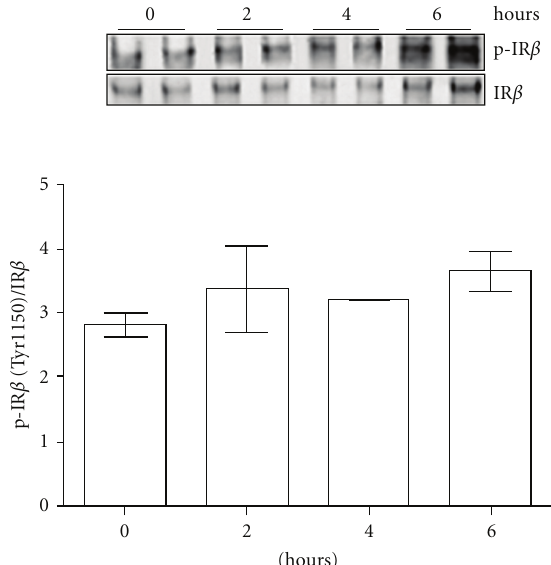
Figure 1: Stability of phosphorylated IR β in mouse brain specimens as a function of postmortem interval. Mice were sacrificed and brain specimens were isolated immediately. Freshly isolated mouse brain specimens were either rapidly frozen or were kept at room temperature for up to a 6hr postmortem interval. Samples were assessed at 2hr postmortem intervals as indicated. Bar graphs represent the ratio of [Tyr1150/1151]-phosphorylated IR β /total IR β as mean ± SEM values. ANOVA; P = . 531; Inset: representative western blot analysis of [Tyr1150/1151]-phosphorylated IR β and total IR β at di ff erent postmortem time intervals as